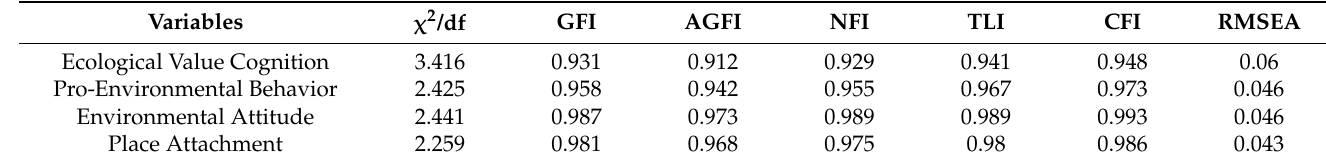
Table 7. Confirmatory factor analysis model fitting